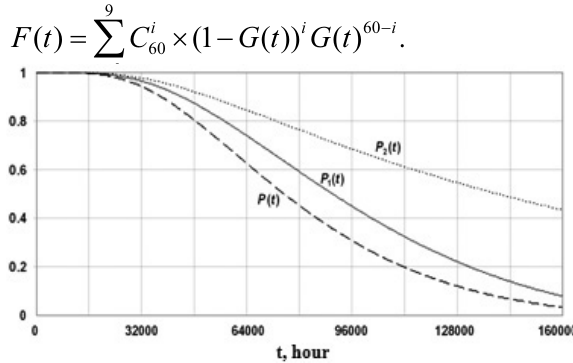
Figure 1. P ( t ) is the SHADR-8 А flowmeter failure probabili - ty; P ( t ) is the probability for the first determining parameter to 1 cross the specified performance level; P the second determining parameter to cross the specified perfor - mance